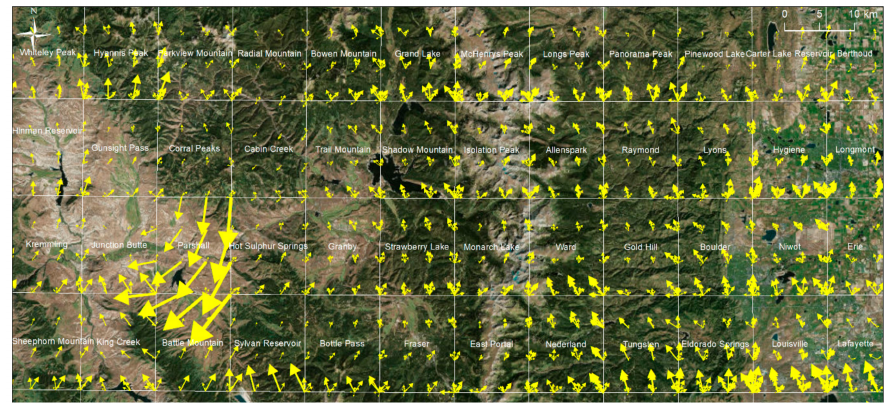
Figure 11. Displacement vector field at GCP locations over multiple USGS map quadrangles of scale 1:24,000, located North-west of Denver (Colorado), reflecting different types of distortions introduced to the map documents during the georeferencing process (basemap source: